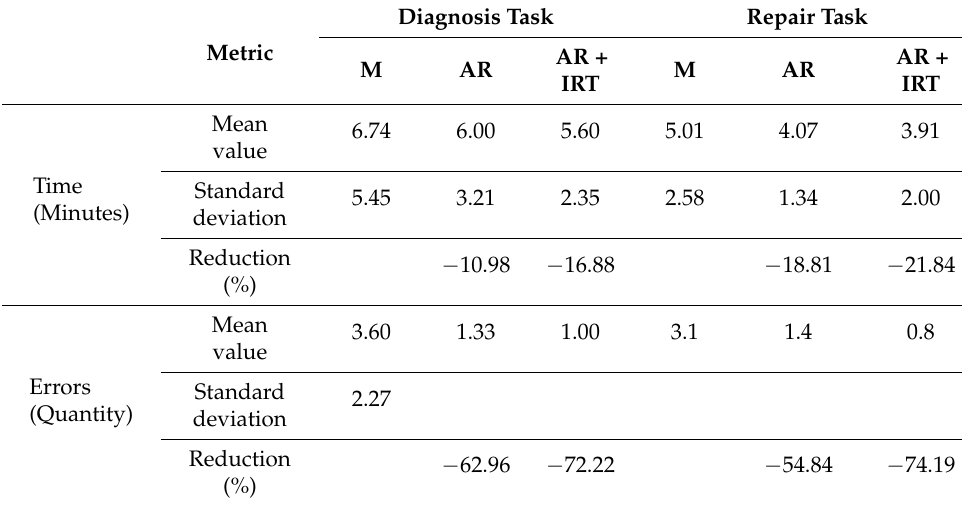
Table 6. Efficiency results of the different industrial maintenance